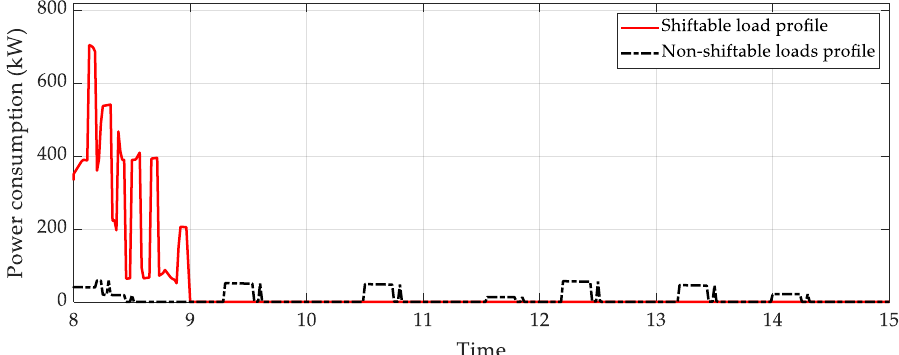
Figure 30. Load profile considered for scheduling.